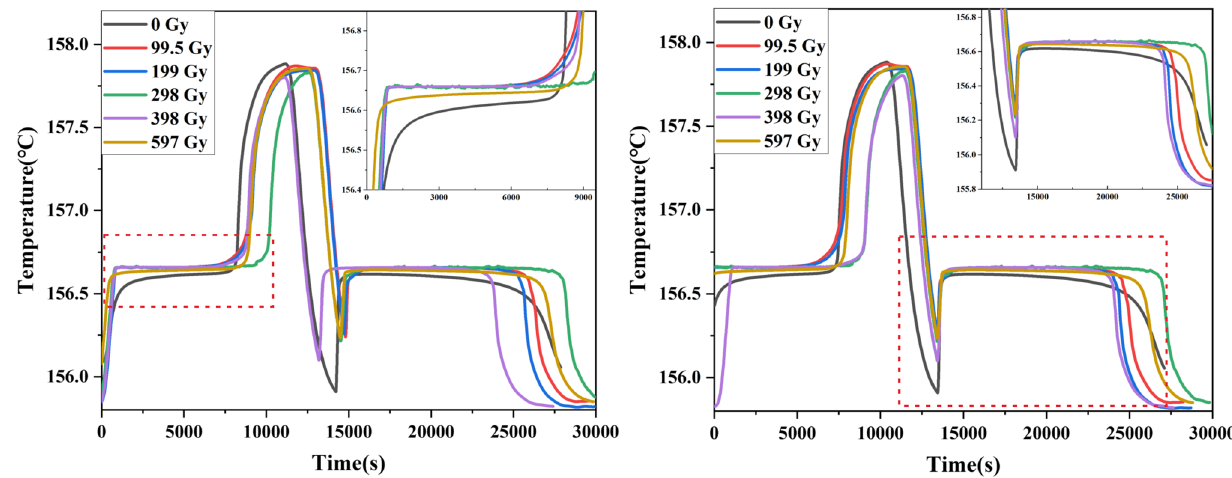
Fig. 11 Melting curves of samples with different irradiation doses and unirradiated samples Table 2 Fixed point crucible experiment with different irradiation doses Irradiation doses Supercooling point/ ◦ C Melting plateau value / ◦ C Melting time/min Freezing plateau value/ ◦